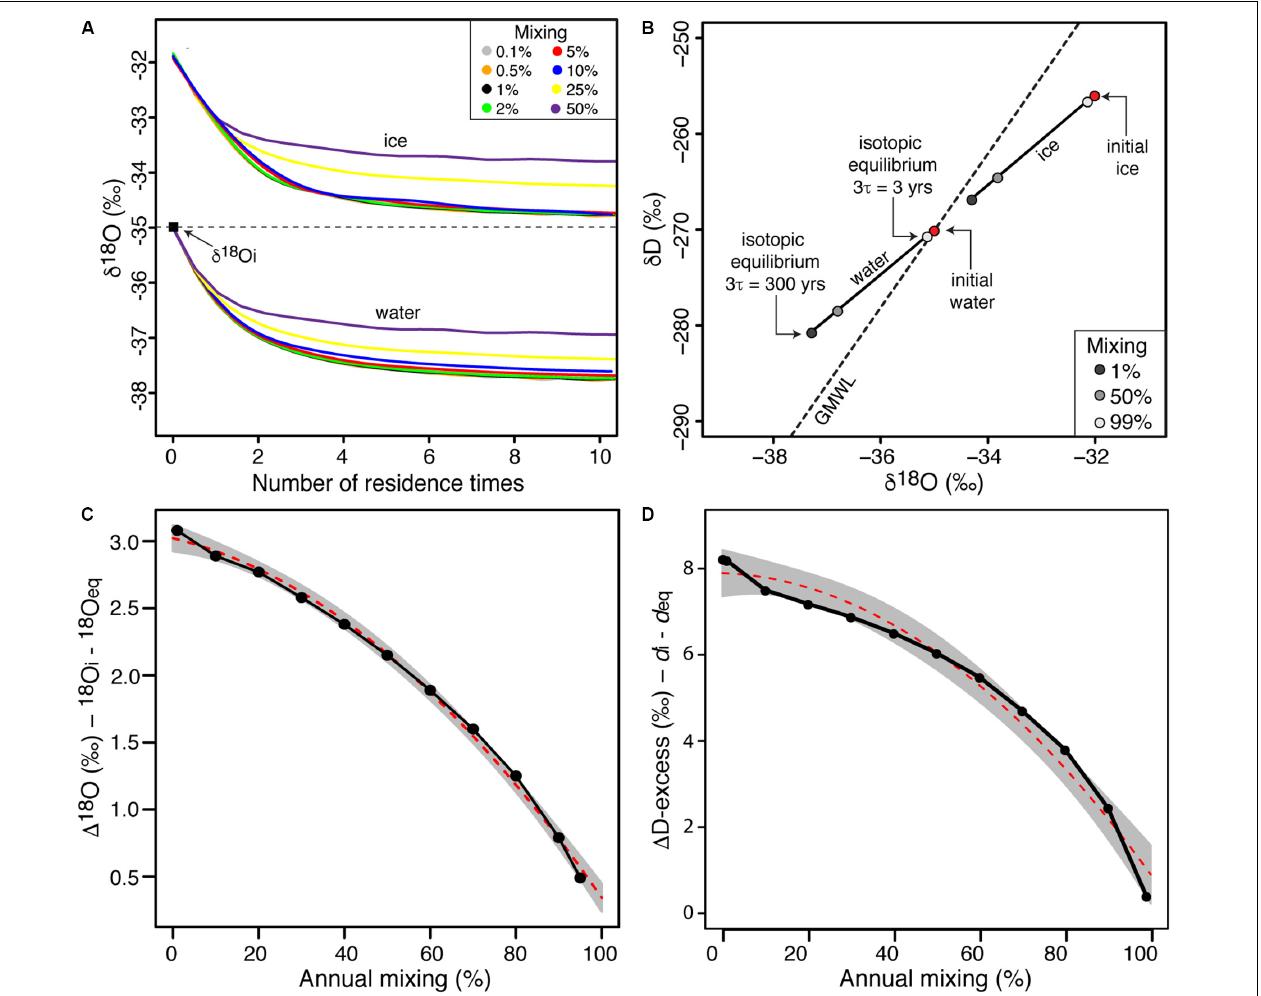
FIGURE 3 | (A) δ 18 O evolution of lake water and forming ice for various annual mixing scenarios as a function of number of residence time (initial δ D- δ 18 O values are –270 and –35 , respectively). The colored lines represent different annual mixing rate scenarios (0.1–50%); (B) δ D- δ 18 O plot of evolving lake water and ice as a function of the annual mixing rates of well-sealed perennially ice-covered lakes. The red dots indicate the δ D- δ 18 O values of initial waters and accreted ice; (C) effect (cid:104) of annual mixing rates in perennially ice-covered lakes on the difference between the initial and steady-state δ 18 O values of lake water; and (D) effect of annual mixing rates in perenially ice-covered lakes on the difference between the initial and steady-state D-excess values of lake water.